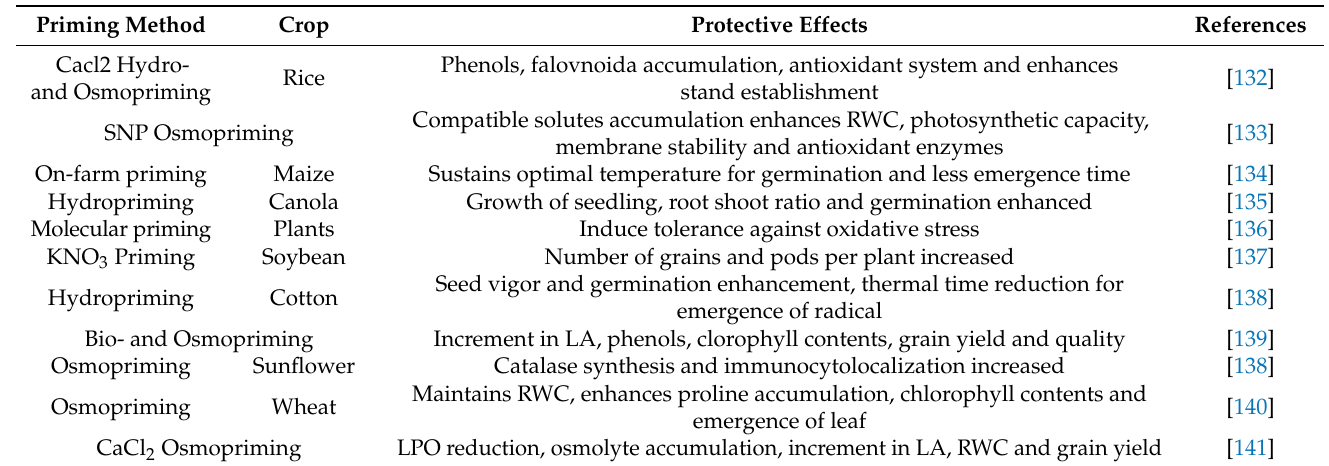
Table 2. Tolerance mechanisms in different field crops through seed-priming